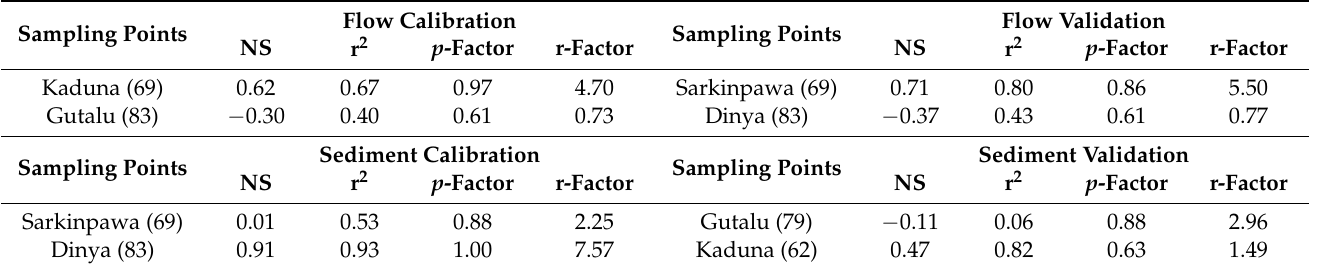
Table 3. Calibration and validation results of the streamflow and sediment concentration across the tributaries of the River